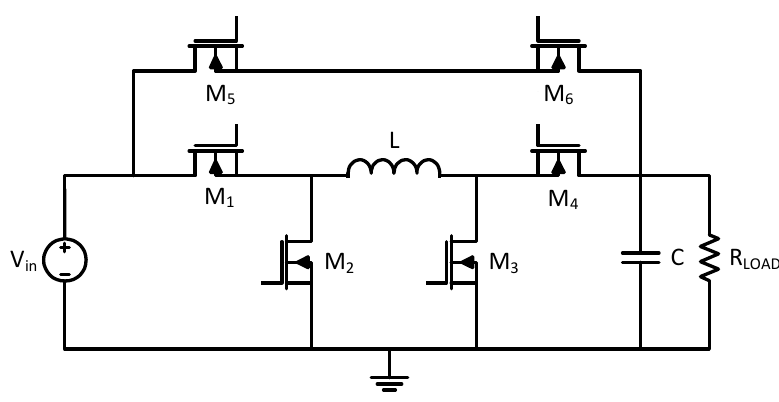
Figure 2. Full-bridge converter simplified diagram.